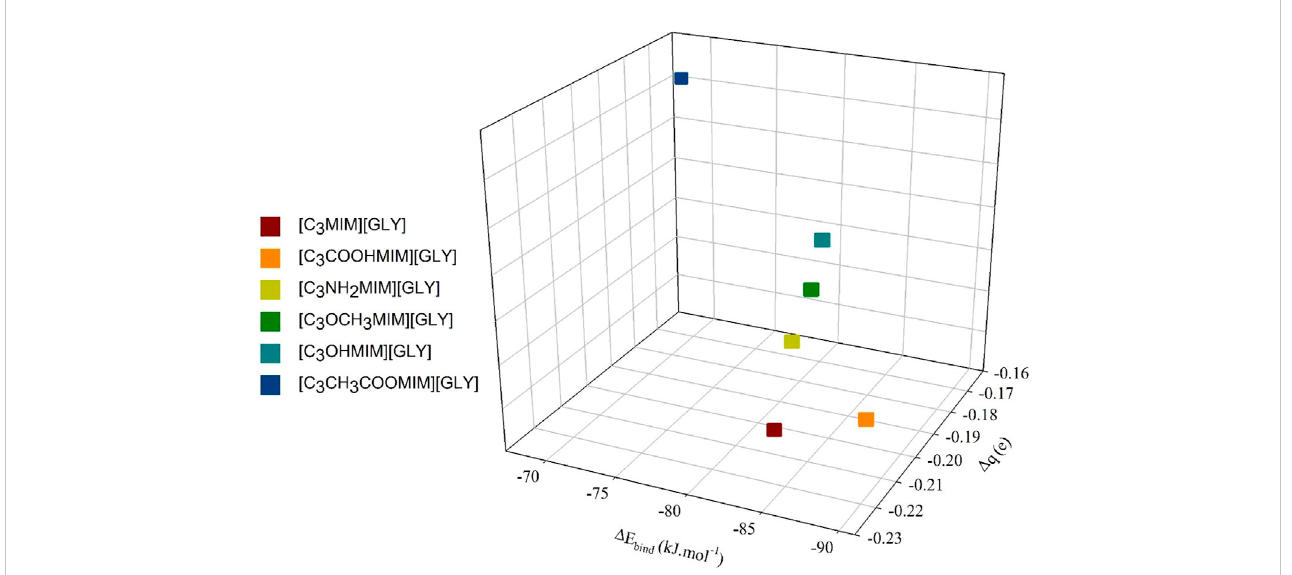
FIGURE 3 SO 2 BE values dependency on NCTA of absorbed SO 2 with the variation of cation functional group.